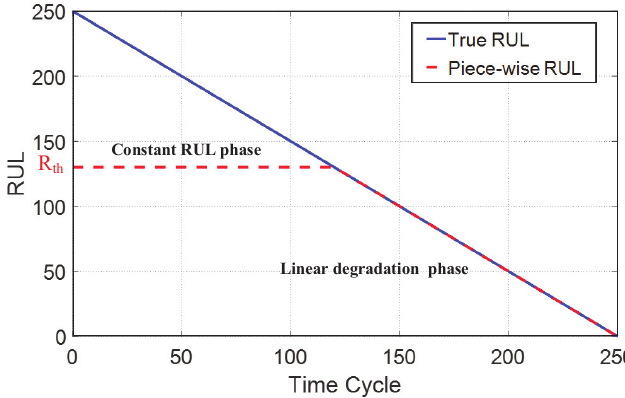
Figure 1. Sensor measurement data from a piece of equipment.